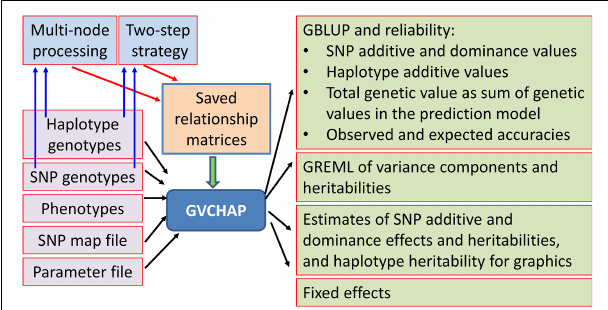
FIGURE 3 | Input and output files of GVCHAP